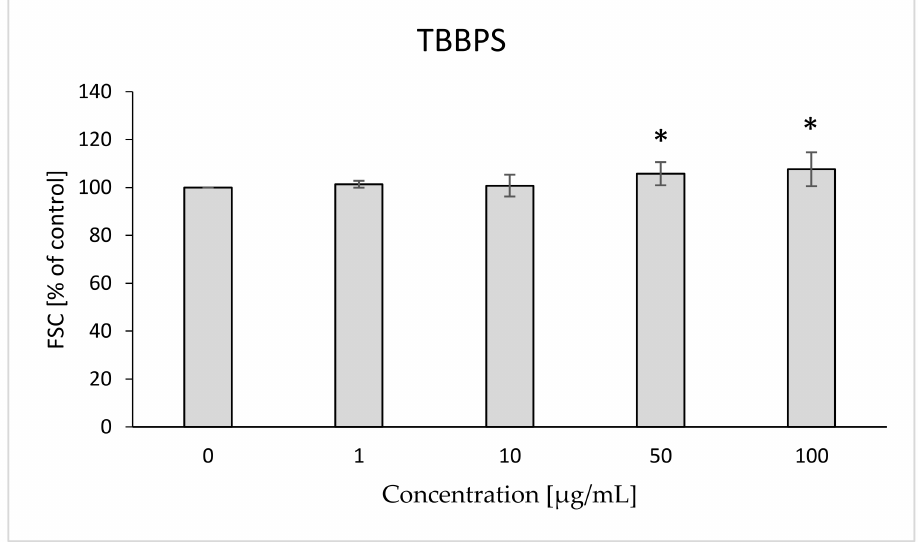
Figure 14. Changes in the FSC parameter in human control erythrocytes and the erythrocytes incubated with TBBPS at 1 to 100 µ g/mL for 48 h. (*) Significantly different from control ( p <